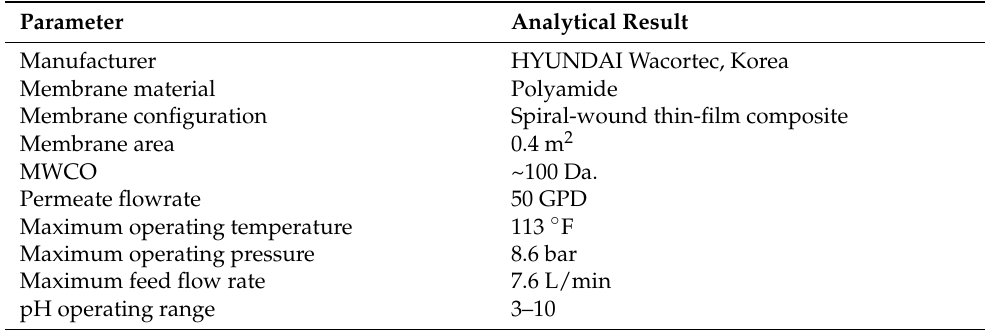
Table 1. Specification of membranes used in this